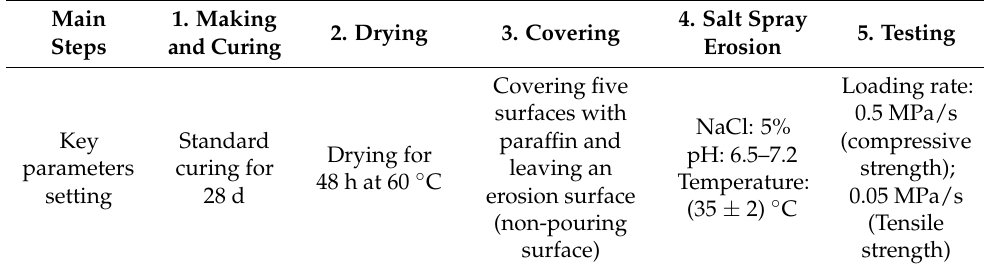
Table 2. Main process of salt spray erosion